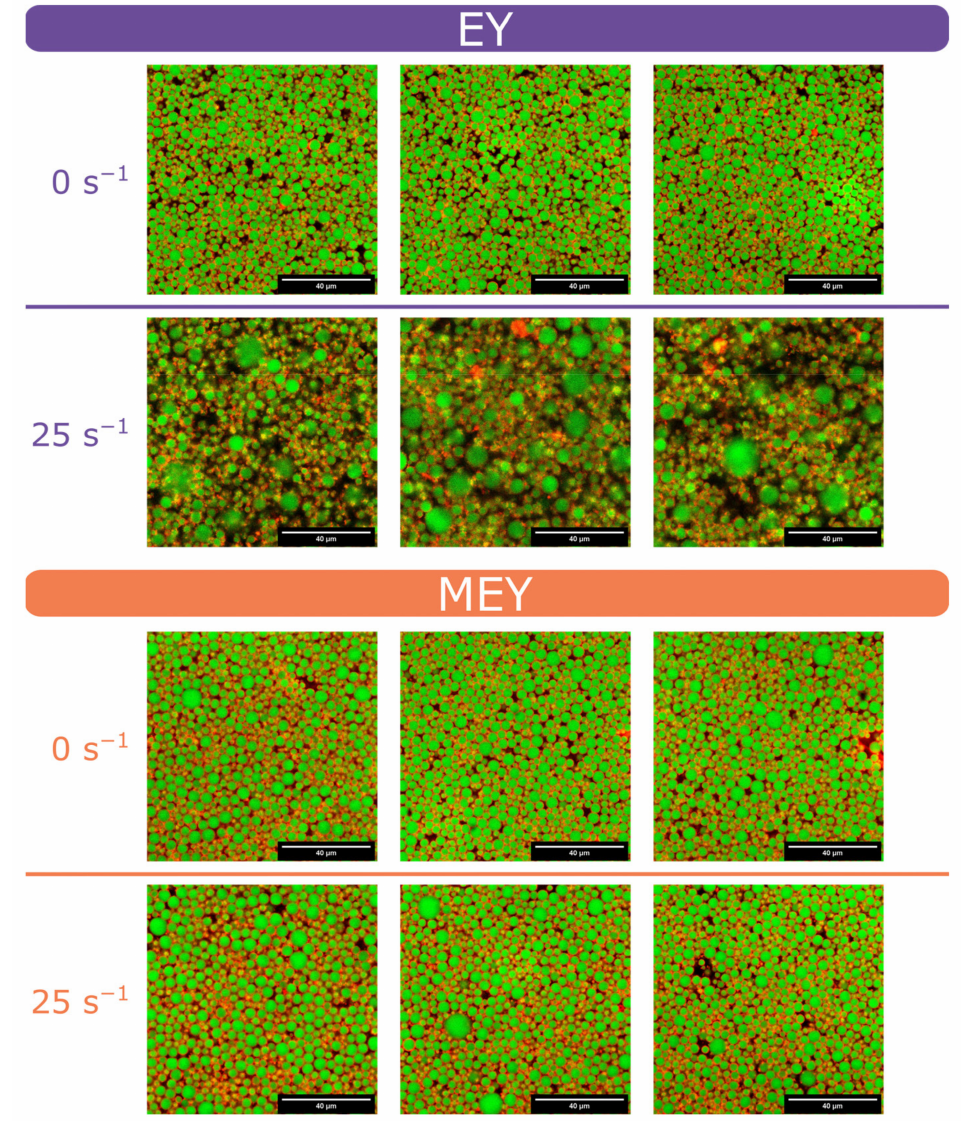
Figure A2. Representative CLSM images of 80% diluted EY (top) and MEY (bottom) emulsions before (0 s − 1 ) and after shearing treatment at 25 s − 1 for 300